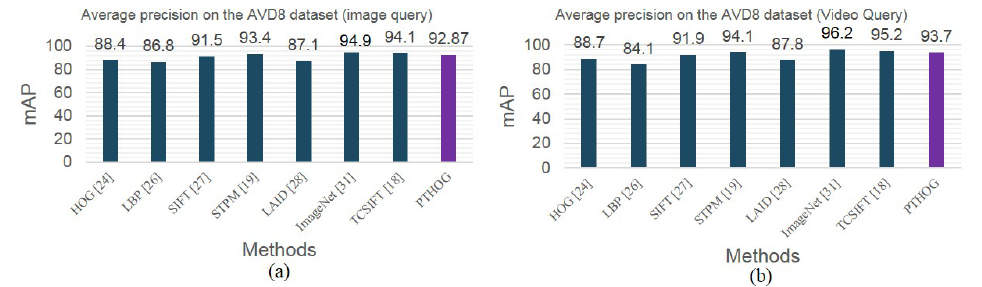
Figure 13. ( a ) Comparison with existing approach on the AVD8 dataset for image query and ( b ) Comparison with existing approach on the AVD8 dataset for video query.